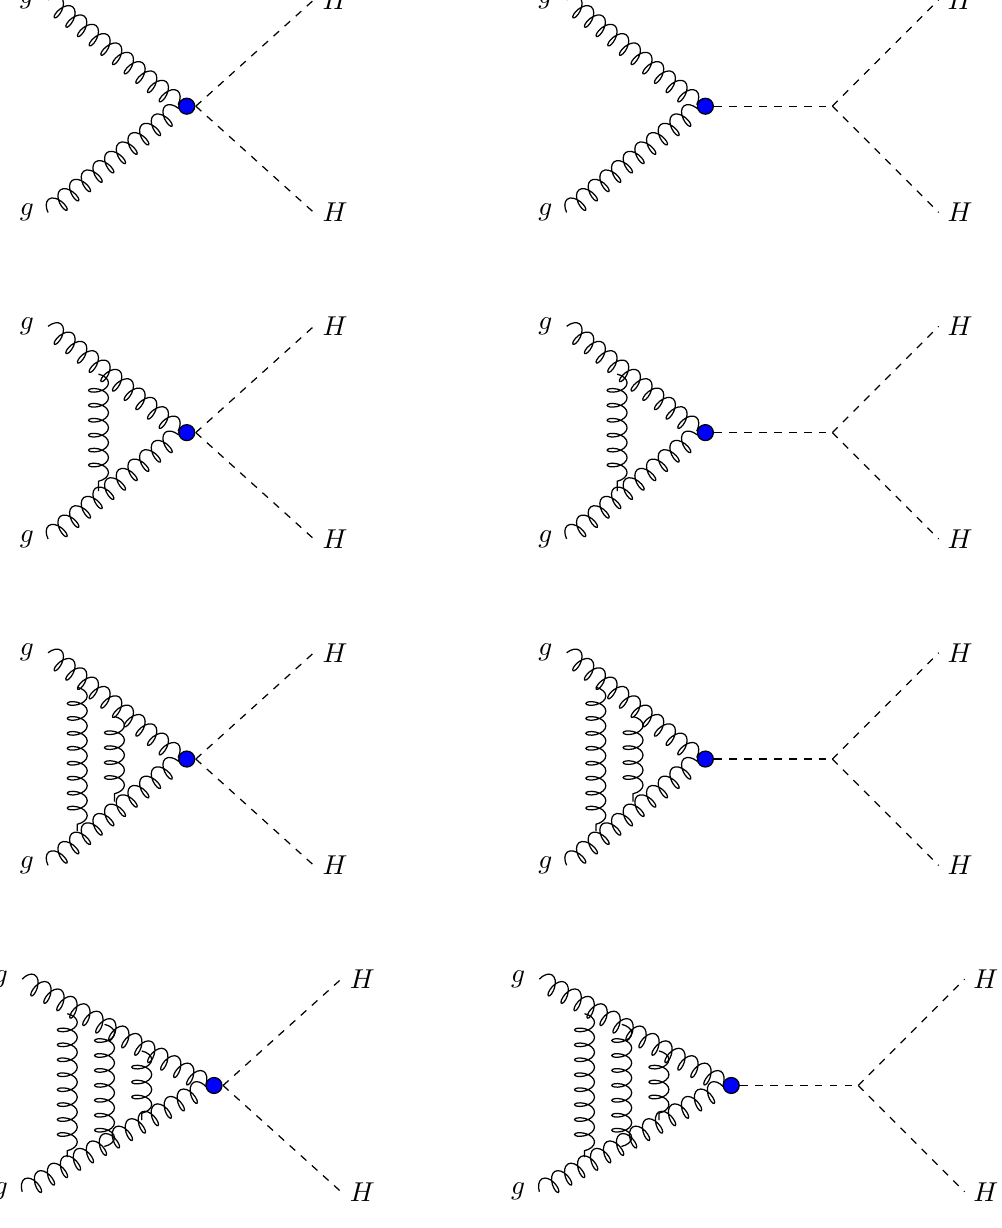
Figure 1 . Class-A: tree, one-, two- and three-loop